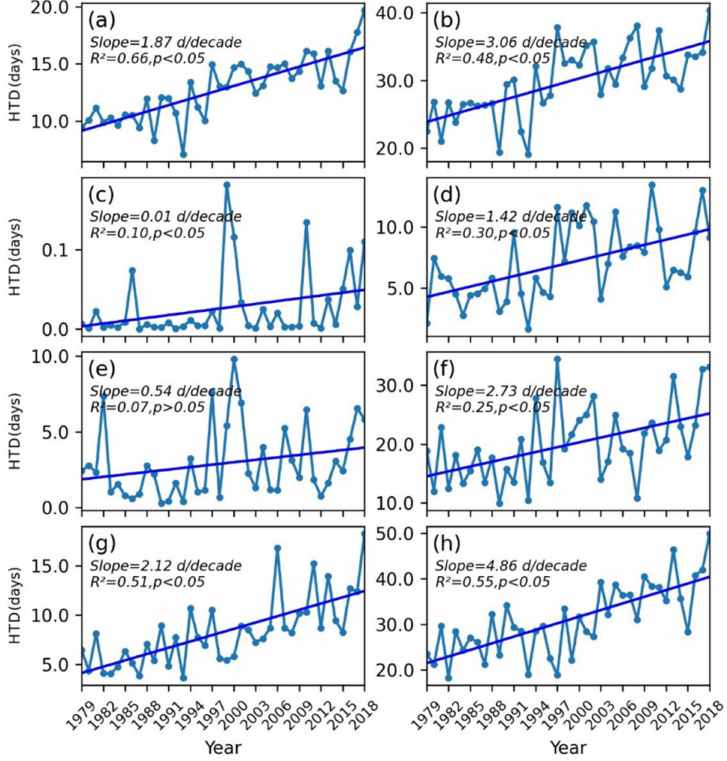
Figure 3. Temporal changes of annual high-temperature days (HTDs) over China and different subregions during 1979–2018. ( a ) China, ( b ) XJ, ( c ) QTP, ( d ) NW, ( e ) NE, ( f ) NC, ( g ) SW, and ( h ) SC. Blue solid line is change trend in